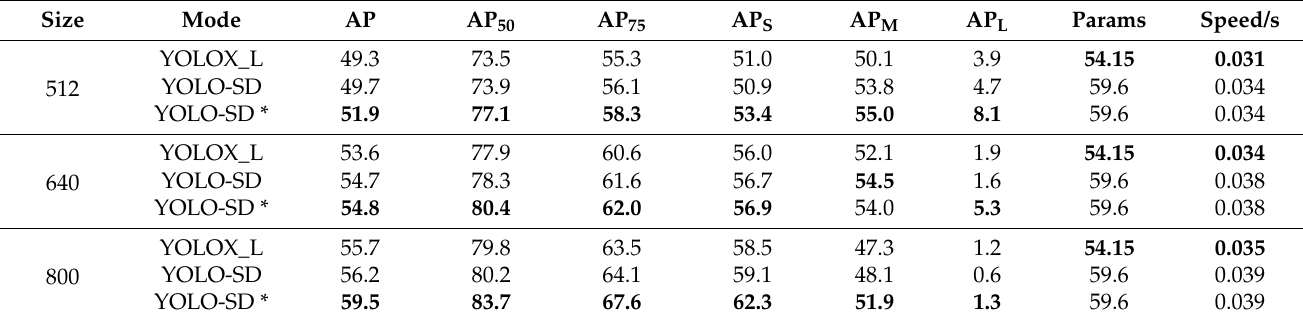
Table 3. Comparison of experimental results of YOLOX_L on